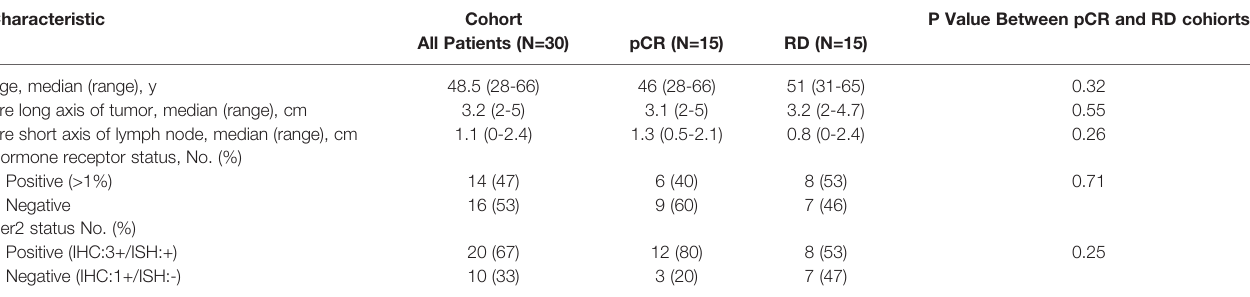
TABLE 1 | Baseline characteristics of the enrolled patients. Characteristic